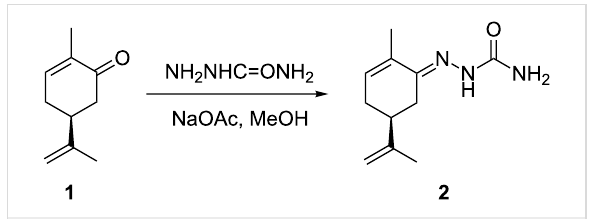
Scheme 1: The reaction of ( R )-( − )-carvone ( 1 ) with semicarbazide to form the corresponding semicarbazone 2